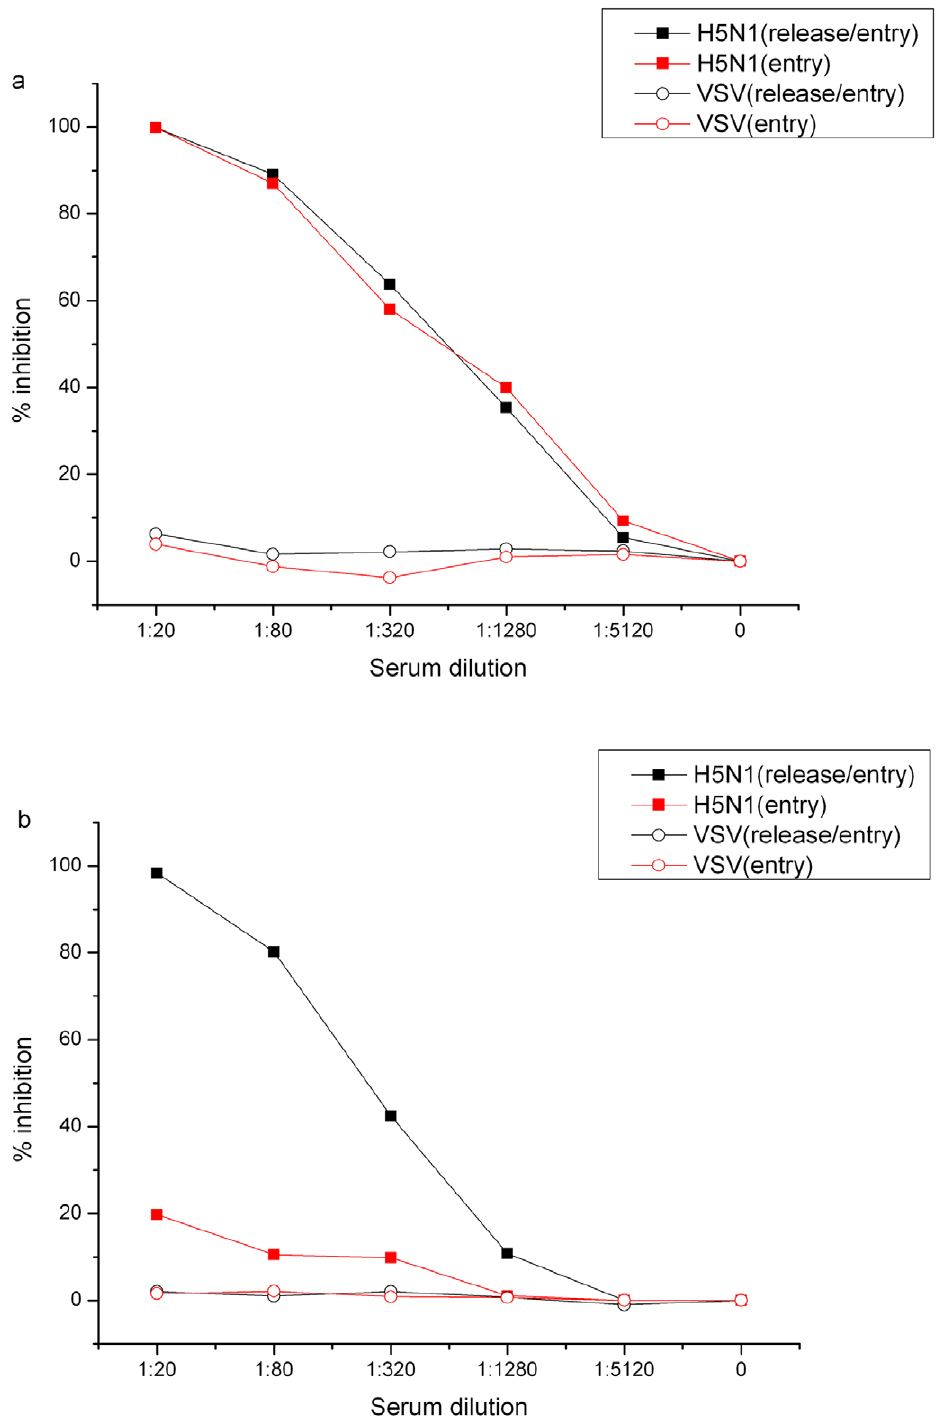
Figure 1. Dissect the role of anti-HA and anti-NA antibodies in influenza HA and NA pseudotype release and entry. a) Titration of anti- HA immune sera by PN entry and PN release/entry assays; b) Titration of anti-NA immune sera by PN entry and PN release/entry assays. Black close square stands for anti-H5N1 neutralizing antibody response measured by PN release/entry assay; Red close square stands for anti-H5N1 neutralizing antibody response measured by PN entry assay; Black open circle stands for anti-VSV-G neutralizing antibody response measured by PN release/entry assay; Red open circle stands for anti-VSV-G neutralizing antibody response measured by PN entry assay.